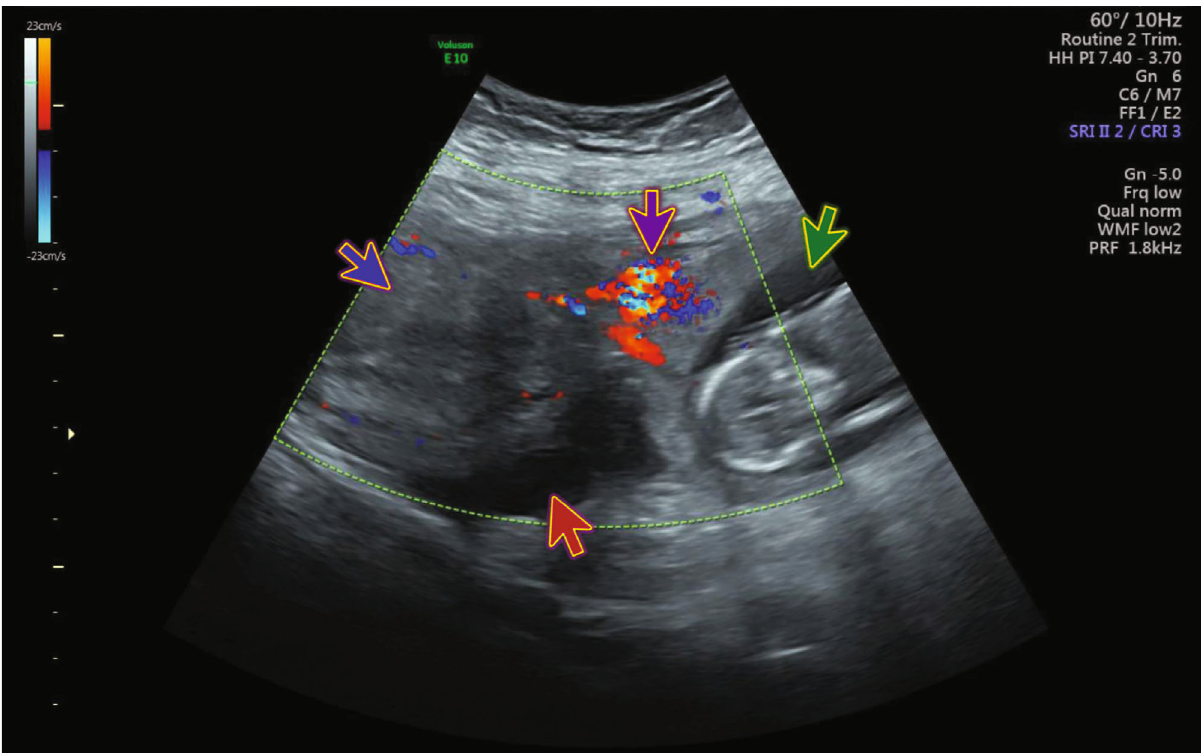
Figure 1: Ultrasound shows the gestational sac (green arrow) that was seen towards the left side of the uterus connected through a vascular stalk (purple arrow) to the uterus (blue arrow) and free fl uid in the pelvis (red